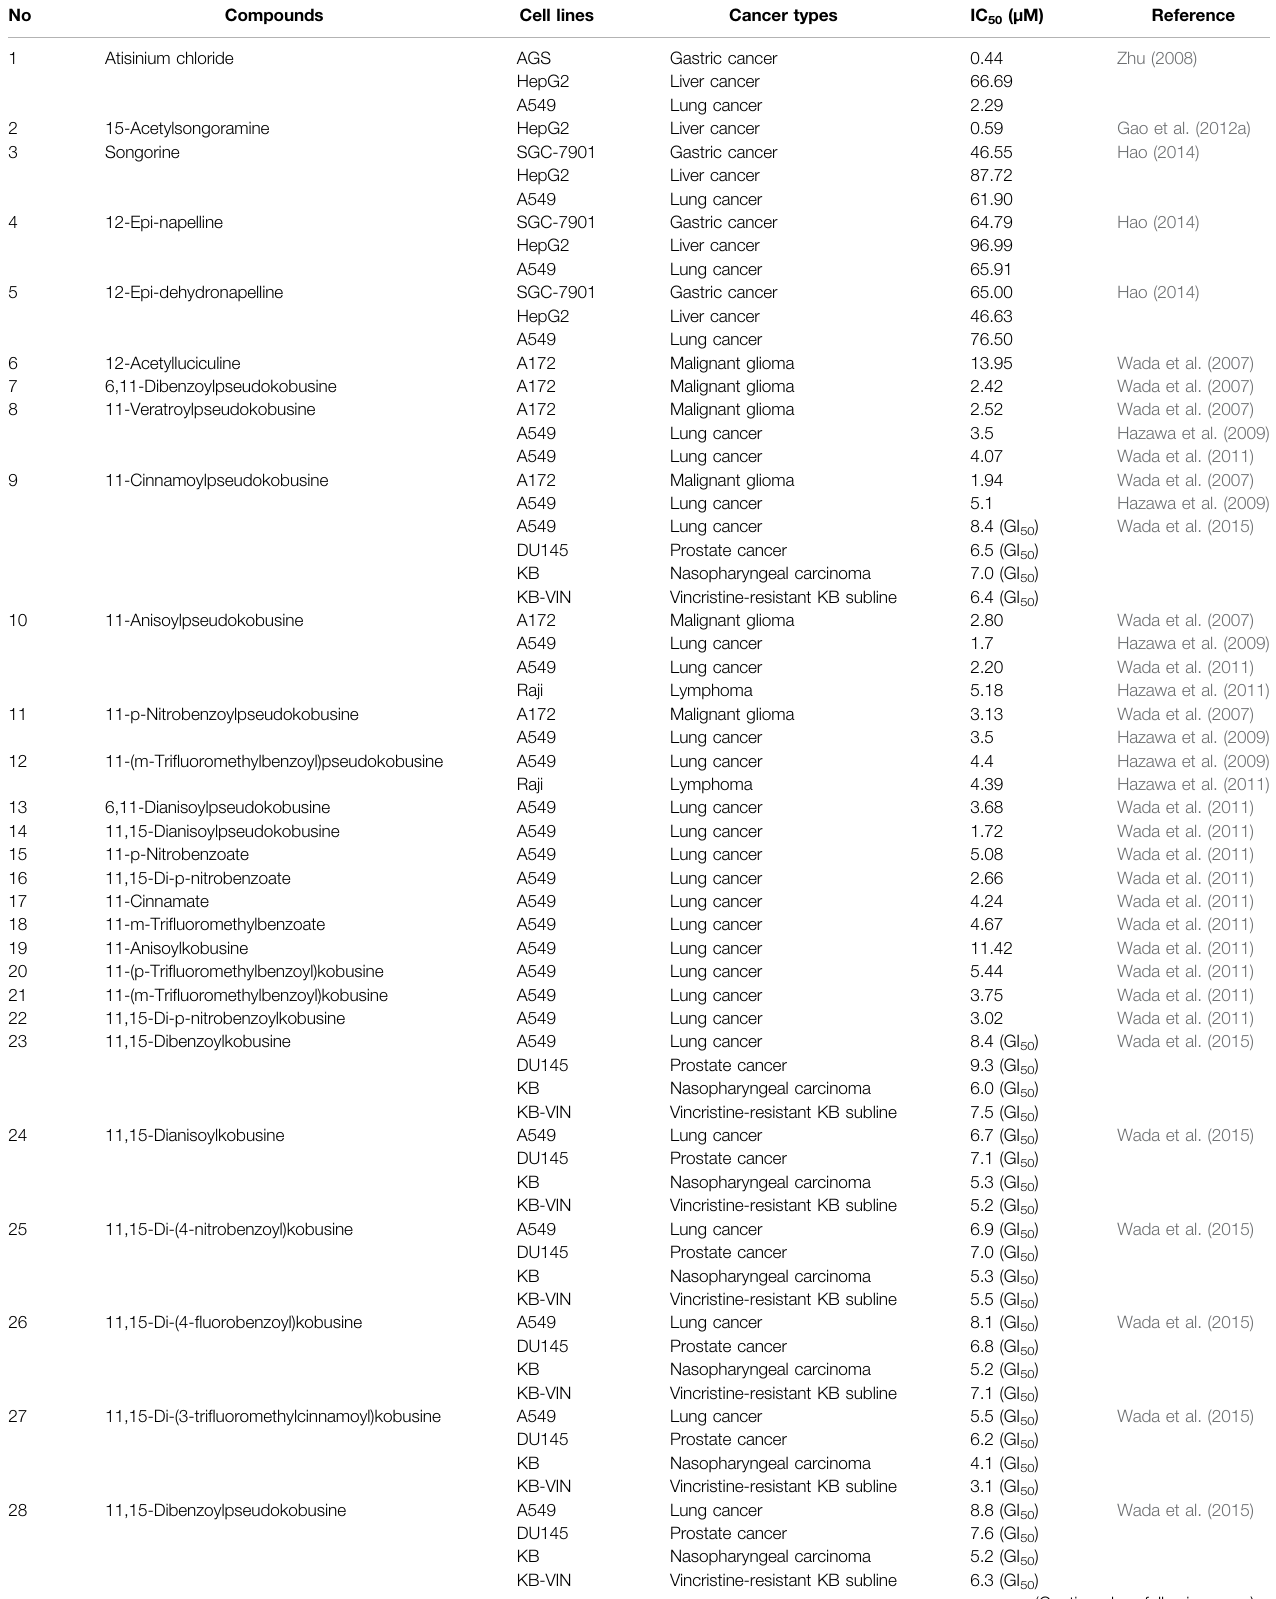
TABLE 3 | Cytotoxicity of C 20 diterpenoid alkaloids and their derivatives in different cancer cell lines. No Compounds Cell